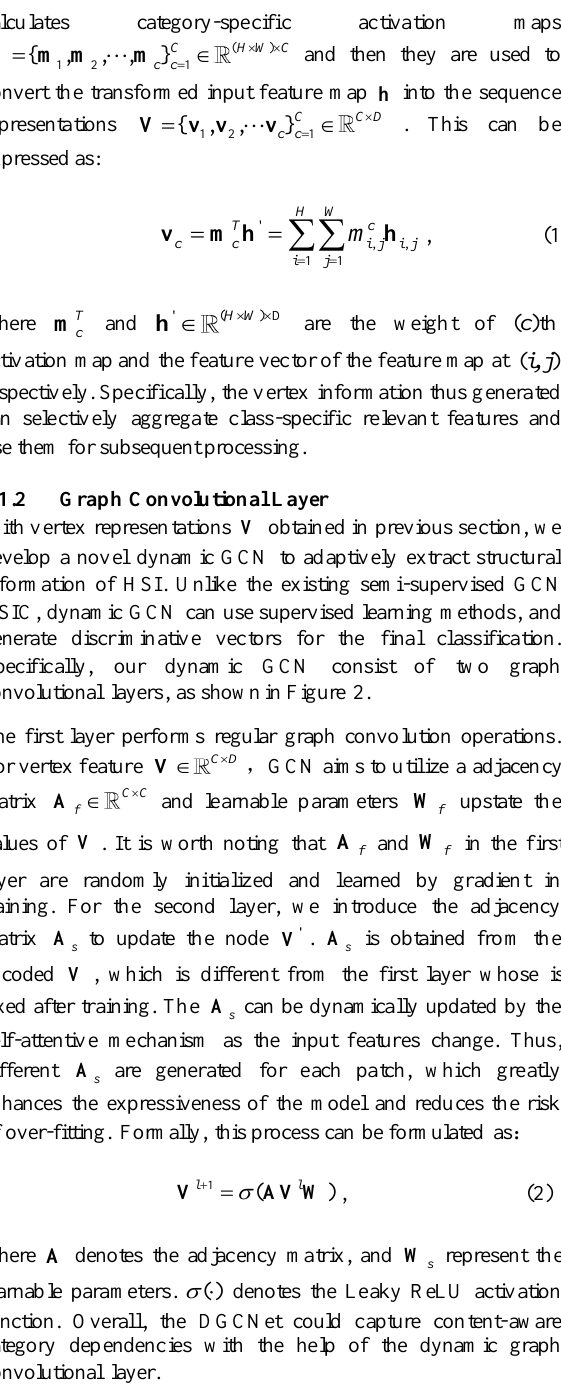
(b), white color indicates dropped neurons, while light blue color indicates normal neurons. Dropout randomly drops discontinuous neurons. Nevertheless, since neighboring neurons information from the vicinity of the dropped activation unit. Figure 3 (c) represents the random continuous regions used by DropBlock. By dropping out a portion of the whole